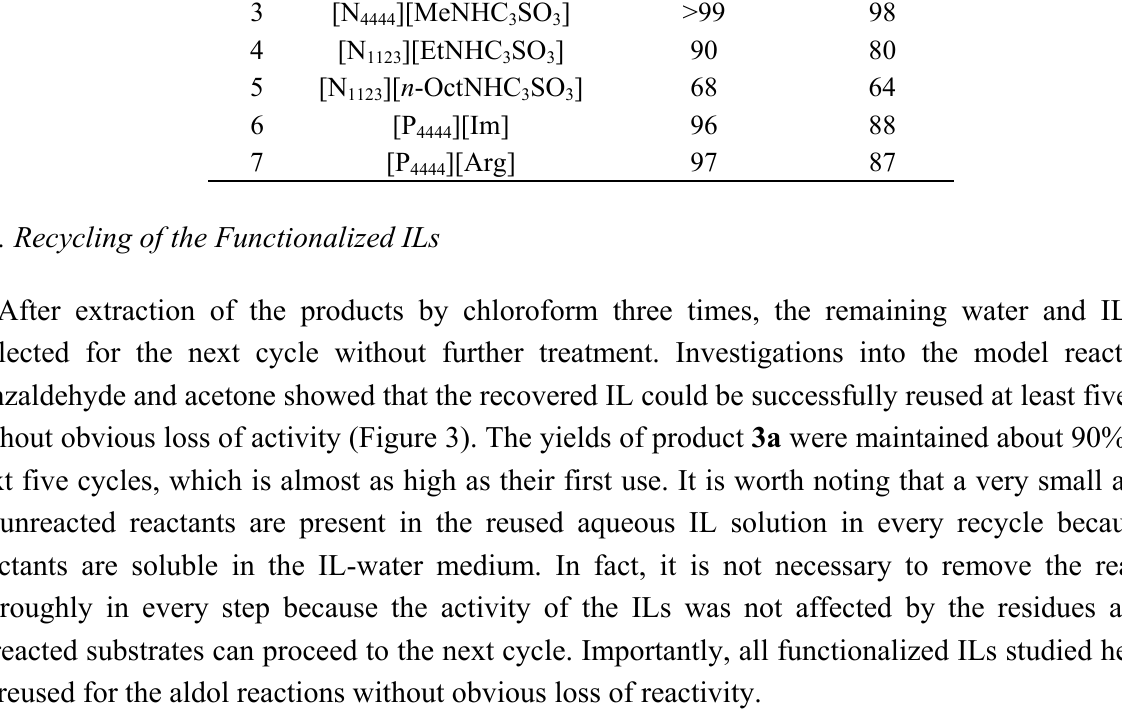
Figure 3. Recycling of [N